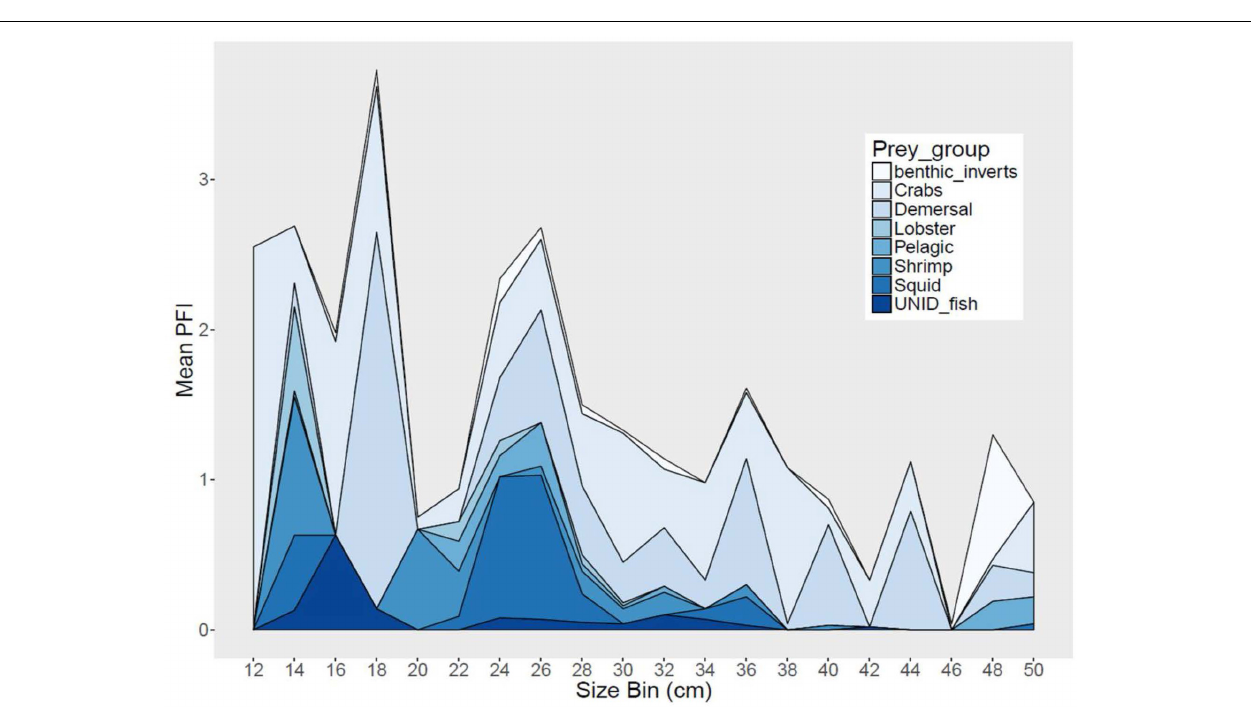
fall (Tukey’s HSD, p < 0.05), and significantly higher than ME fish in the summer. In addition, δ 15 N values of ME fish were significantly higher than those of NMA fish. Finally, δ 15 N values for ME fish were significantly higher in the fall compared to